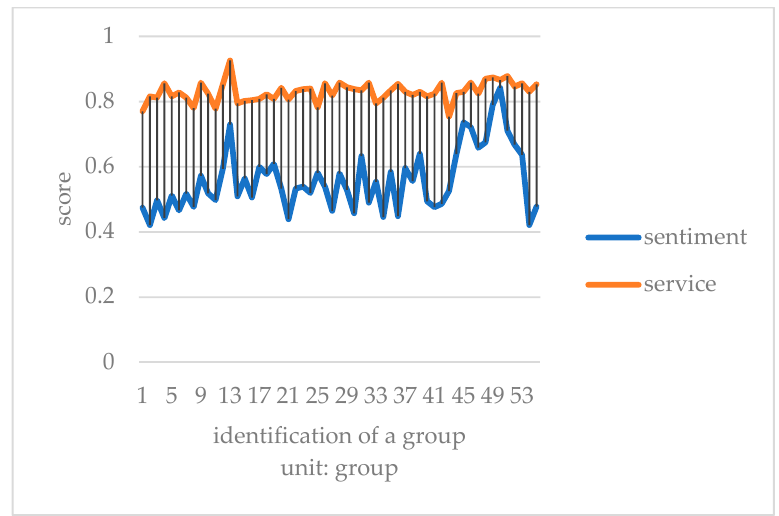
Figure 12. Chart of emotional score and restaurant service afterCOVID-19.